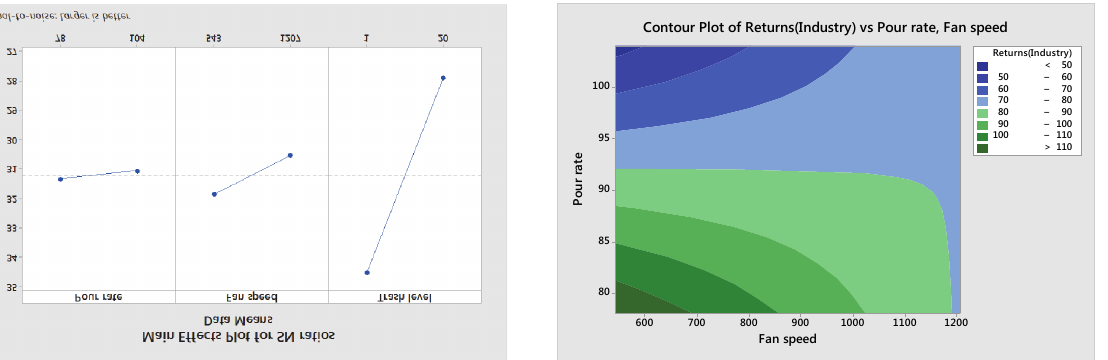
Fig. 9. Main effects Plots for SN rations for the production factors